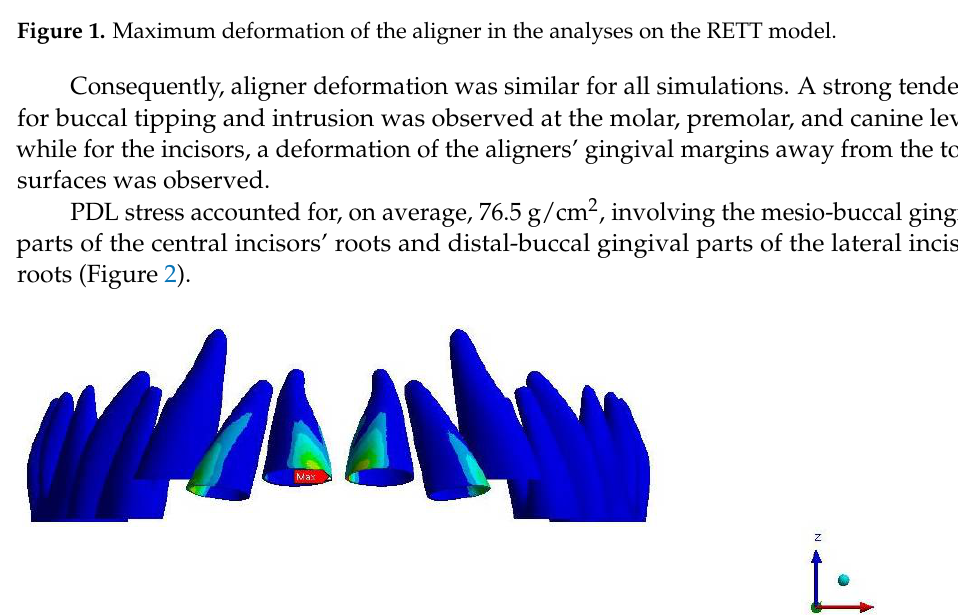
Figure 2. Amount of stress on the PDL based on the analyses on the RETT model. Regarding aligner pressure (Table 2), differences depending on the attachments’ set- tings were reported. In all simulations, pressure areas were located on buccal and palatal gingival margins of incisors. For NOATT, ATT3-7, ATT1-2, and OTT, maximum pressure ar- eas were located on the lateral incisors’ buccal gingival surfaces, while in RETT and PALAT, they were located on the occlusal surface of rectangular attachments (Tables 3 and